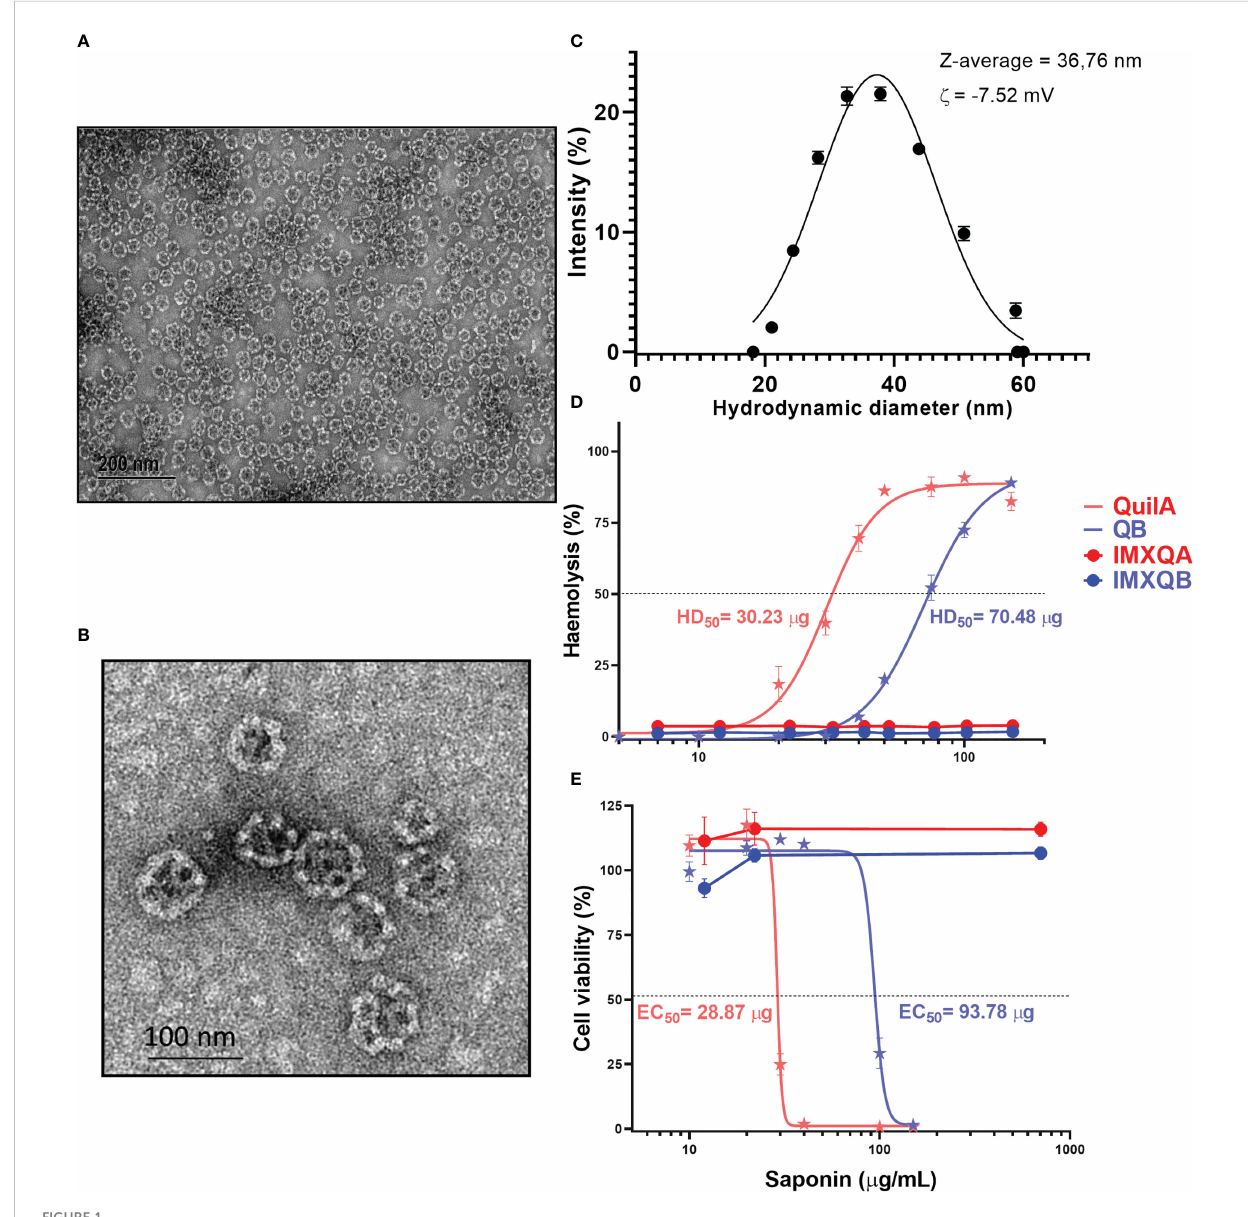
FIGURE 1 IMXQB nanoparticle characterization. (A) Transmission electron microscopy (TEM) image of an IMXQB nanoparticle. (B) High-magni fi cation IMXQB TEM image. Images were obtained after negative staining with uranyl acetate. (C) IMXQB size distribution determined by dynamic light scattering (DLS) measurements. (D) Hemolytic activity of Q. brasiliensis (QB) and Quil A ® saponins and their nanoparticulate formulations (IMXQB and IMXQA). (E) Madin – Darby canine kidney cell line (MDCK) cytotoxicity of QB or Quil A ® saponins and their nanosized formulations (IMXQB and IMXQA). Cell viability was measured by MTT (3-(4,5-dimethylthiazol-2-yl)-2,5-diphenyl-2H-tetrazolium bromide) assay 24 hours after treatment. All results are presented as the mean value ± standard deviation. HD 50 (hemolytic dose 50%) and IC 50 (half-maximal inhibitory concentration values) were calculated and plotted in GraphPad Prism